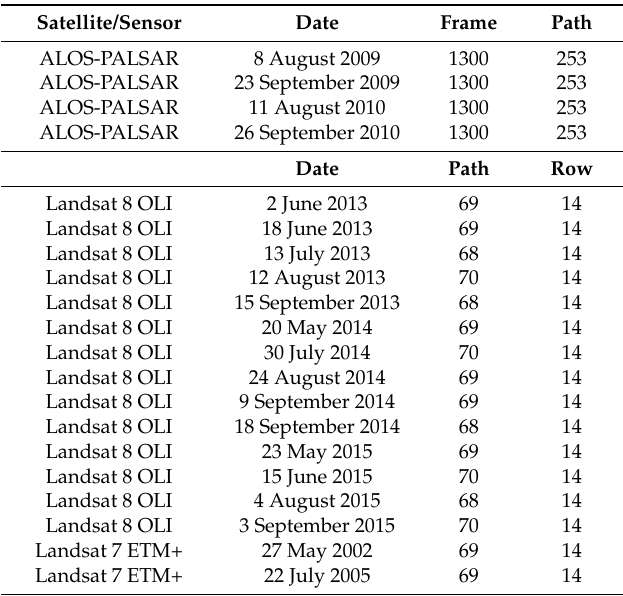
Table 2. Satellite remote sensing scenes used in